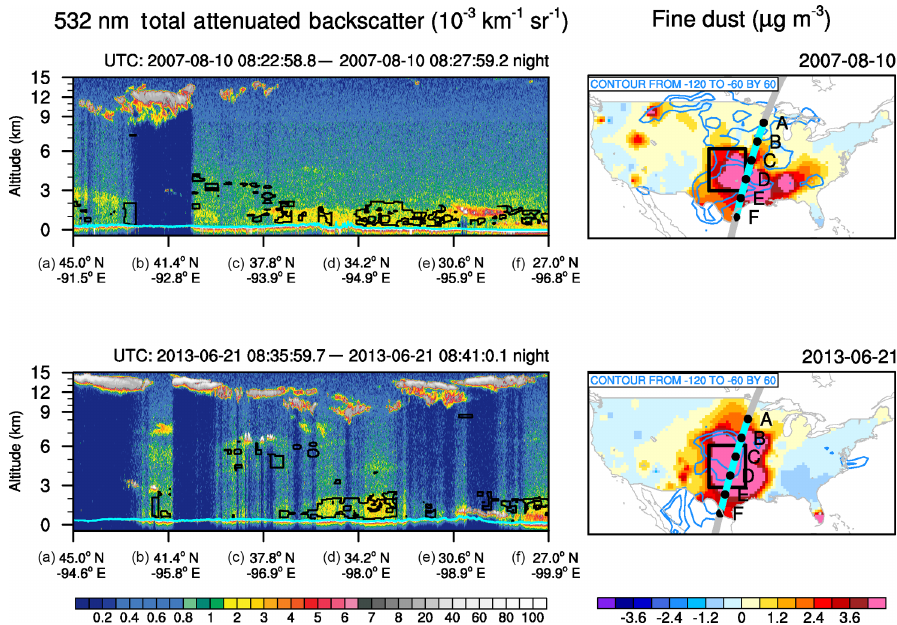
Figure 7. Nighttime 532nm total attenuated backscatter (shading) and depolarization ratio (black contours, values ≥ 0.2 are shown) from CALIOP on 10 August 2007 (top left) and on 21 June 2013 (bottom left), along with daily anomalies of fine dust concentration (µgm − 3 ; shading, right column) and CIN (blue contour, only negative values from − 60 to − 120Jkg − 1 are shown). CALIOP orbit tracks are shown in grey lines (right column) with the cyan part and sampling points (a–f) denoting the cross section shown in the left column. Black boxes denote the CGP region.